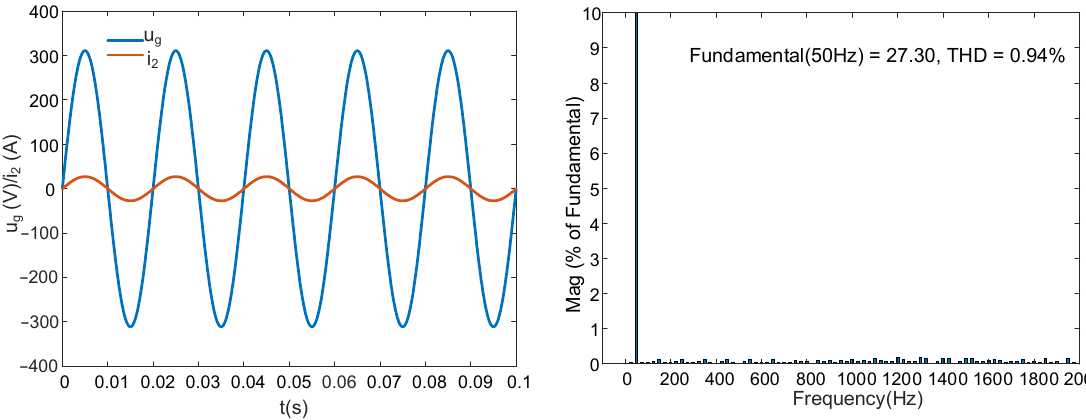
Figure 14. Simulation results of the “FOGCI + IOPI” system with α + β = 2.